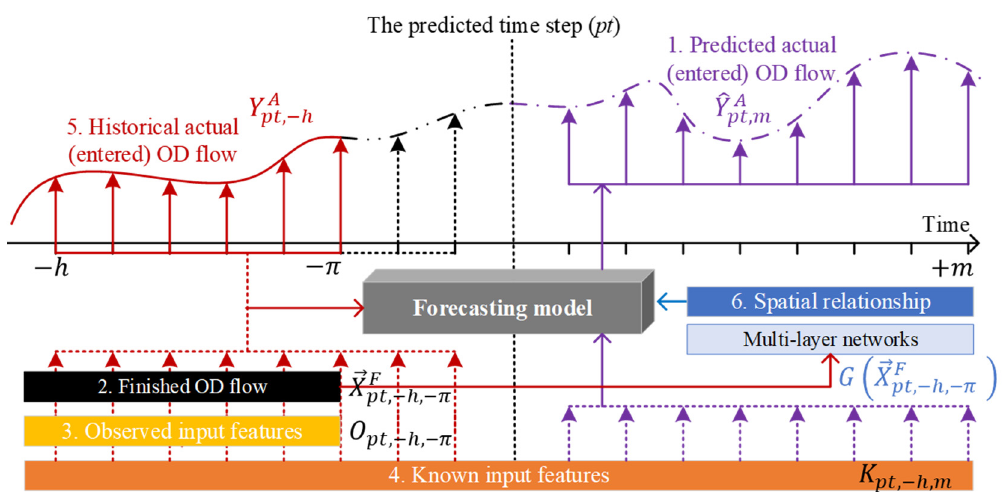
Figure 1. Illustration of the forecasting task in the temporal perspective. Table 1. Key notations in forecasting